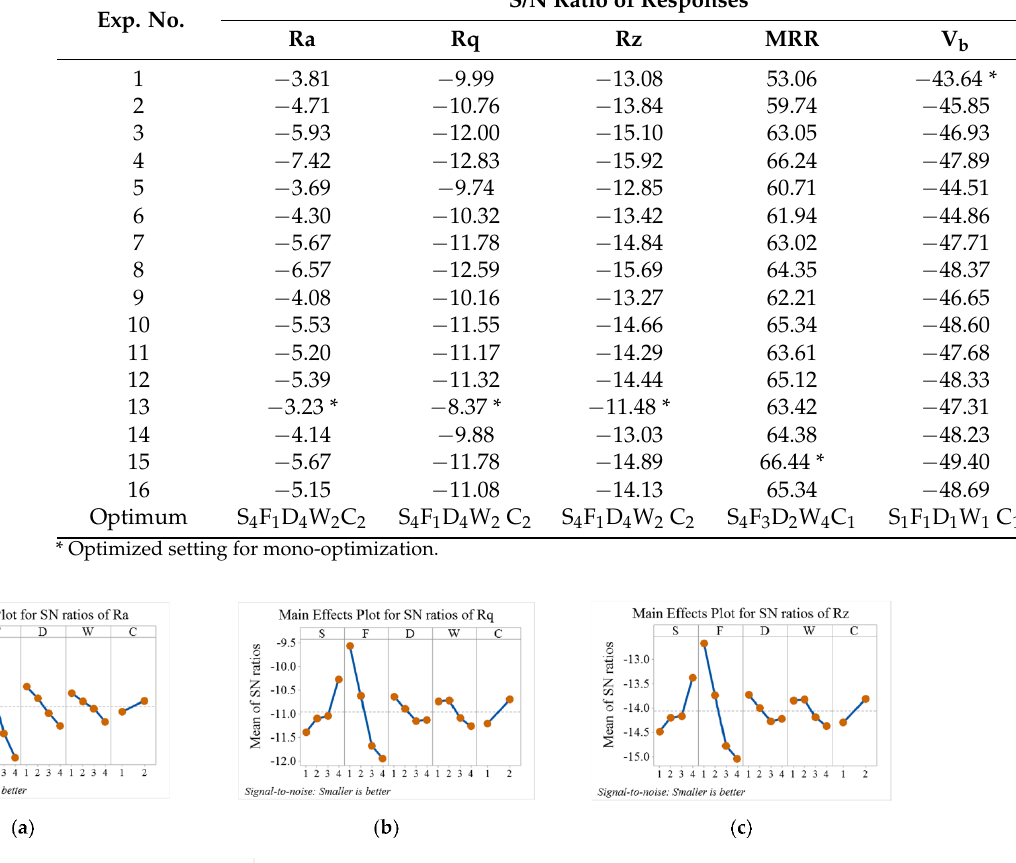
Table 6. S/N ratios of responses.